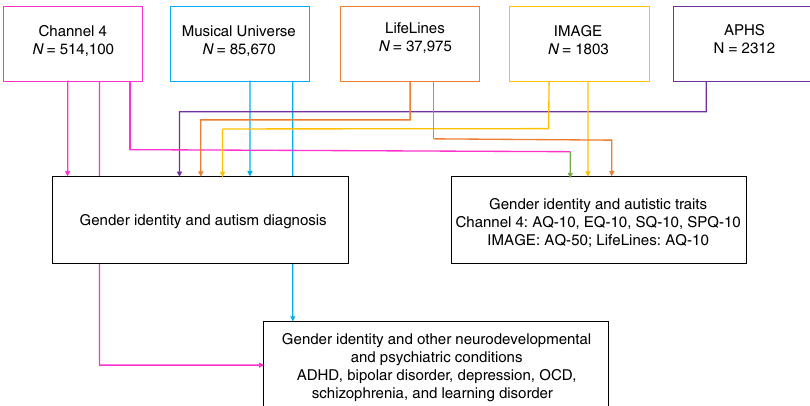
Fig. 1 Schematic diagram of the study. This fi gure provides a schematic overview of the study. In this study we investigated three questions, presented in the red boxes. For each question, the primary dataset was the Channel 4 dataset (pink box). We used four validation datasets to validate the results — Musical Universe (cyan box), LifeLines (orange box), IMAGE (yellow box), and APHS (purple box). Colored arrows from the dataset boxes to the questions indicate which questions were investigated in which datasets. AQ-10 (Autism Spectrum Quotient-10), SQ-10 (Systemizing Quotient-10), EQ-10 (Empathy Quotient-10), SPQ-10 (Sensory Perception Quotient-10), AQ-50 (Autism Spectrum Quotient-50), ADHD (Attention-De fi cit/Hyperactivity Disorder), OCD (Obsessive-Compulsive